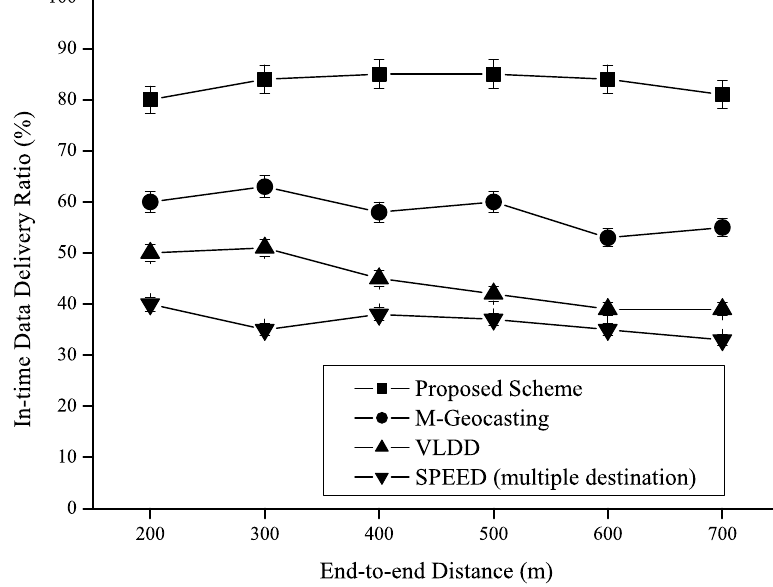
Figure 6. Comparison of in-time data delivery ratio according to end-to-end